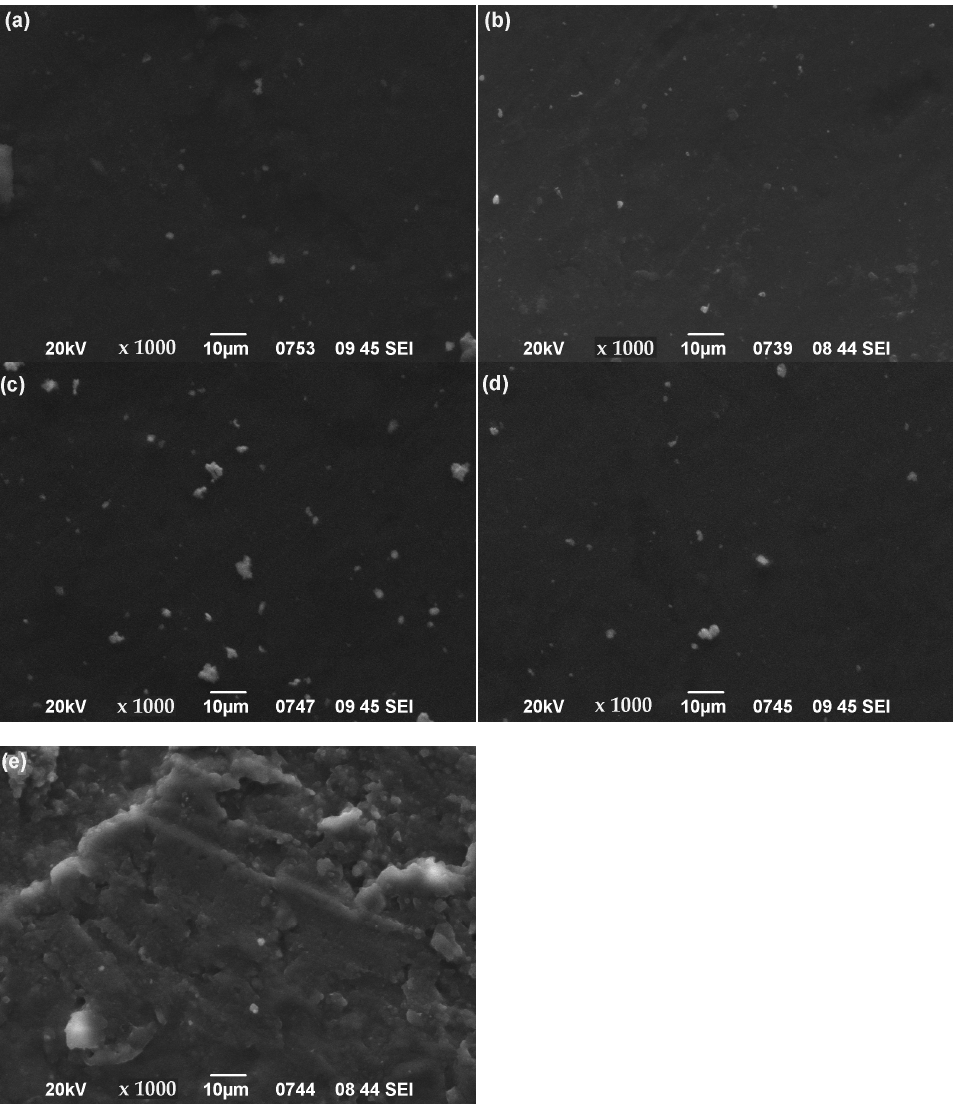
Figure 5. SEM microphotos taken for dental nanocomposite resins filled with 22 wt% of: ( a ) neat silica; ( b ) S.MPS; ( c ) S.QAMTMSi; ( d ) S.QAMTESi; ( e ) S.QAPTESi nanoparticles (×1000 magnification).